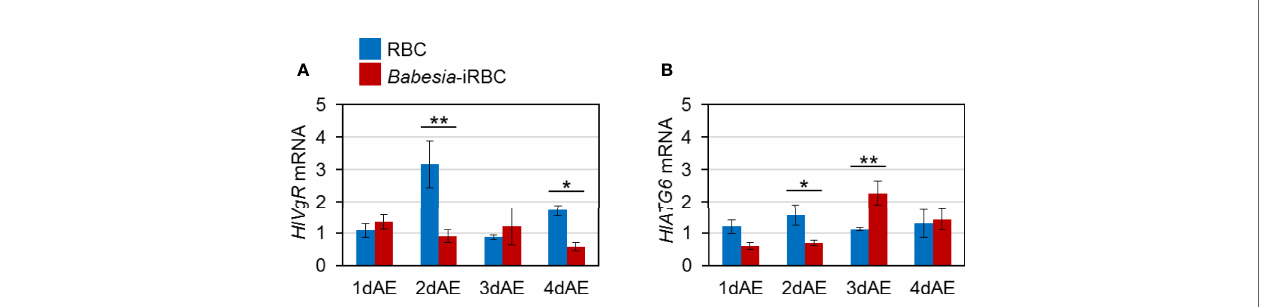
FIGURE 3 | mRNA expression analysis of (A) vitellogenin receptor ( HlVgR ) and (B) autophagy-related gene 6 ( HlATG6 ) in the ovary after semiarti fi cial mouse skin membrane feeding with bovine red blood cells (RBC group) or with Babesia -infected bovine red blood cells ( Babesia -iRBC group). Relative expression levels from extracted total RNA were determined by real-time PCR as shown in Figure 2 . Data represent the mean ± SD of triplicated samples. Asterisks indicate the signi fi cant differences between the RBC and Babesia -iRBC groups (* P < 0.05, ** P < 0.01 using the Tukey –